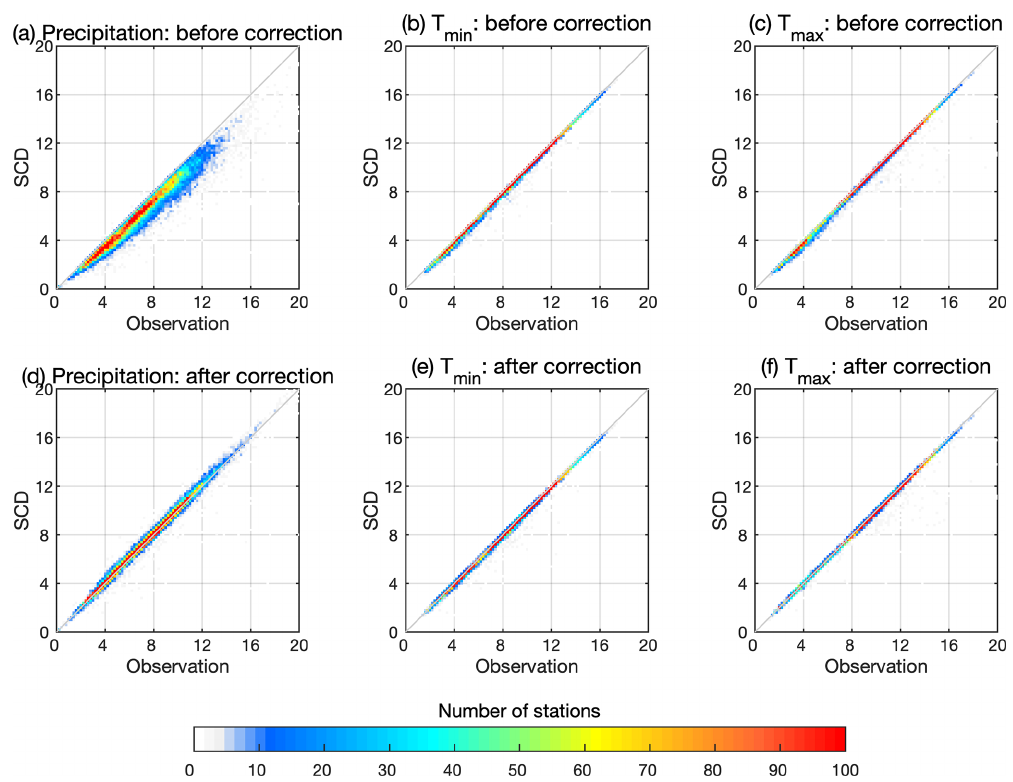
Figure 11. The SD of observations and SCDNA estimates before and after correction. Data from the observation period are